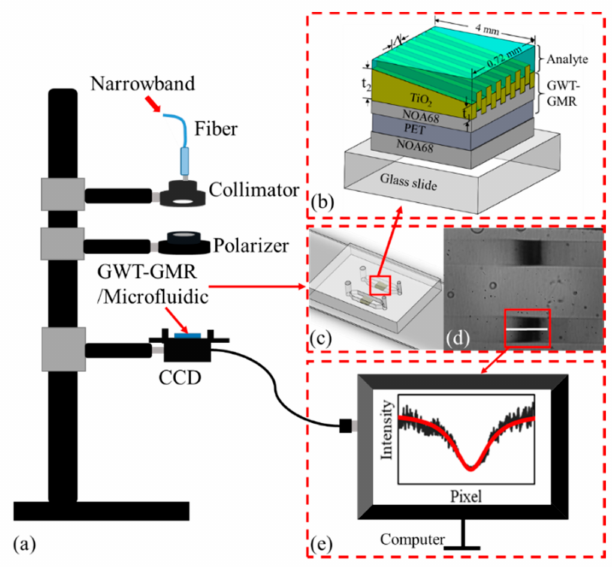
Figure 1. ( a ) Illustration of the transmission setup, ( b ) schematic of a gradient waveguide thickness guided-mode resonance (GWT-GMR) sensor bonded on a glass slide, ( c ) and two-channel microfluidic chip embedded with GWT-GMR sensors. ( d ) Examples of the transmission intensity distributions on a charge-coupled device (CCD). ( e ) The raw (black) and fitted (red) intensity distributions along a specific row of pixels, that is, the white line in ( d